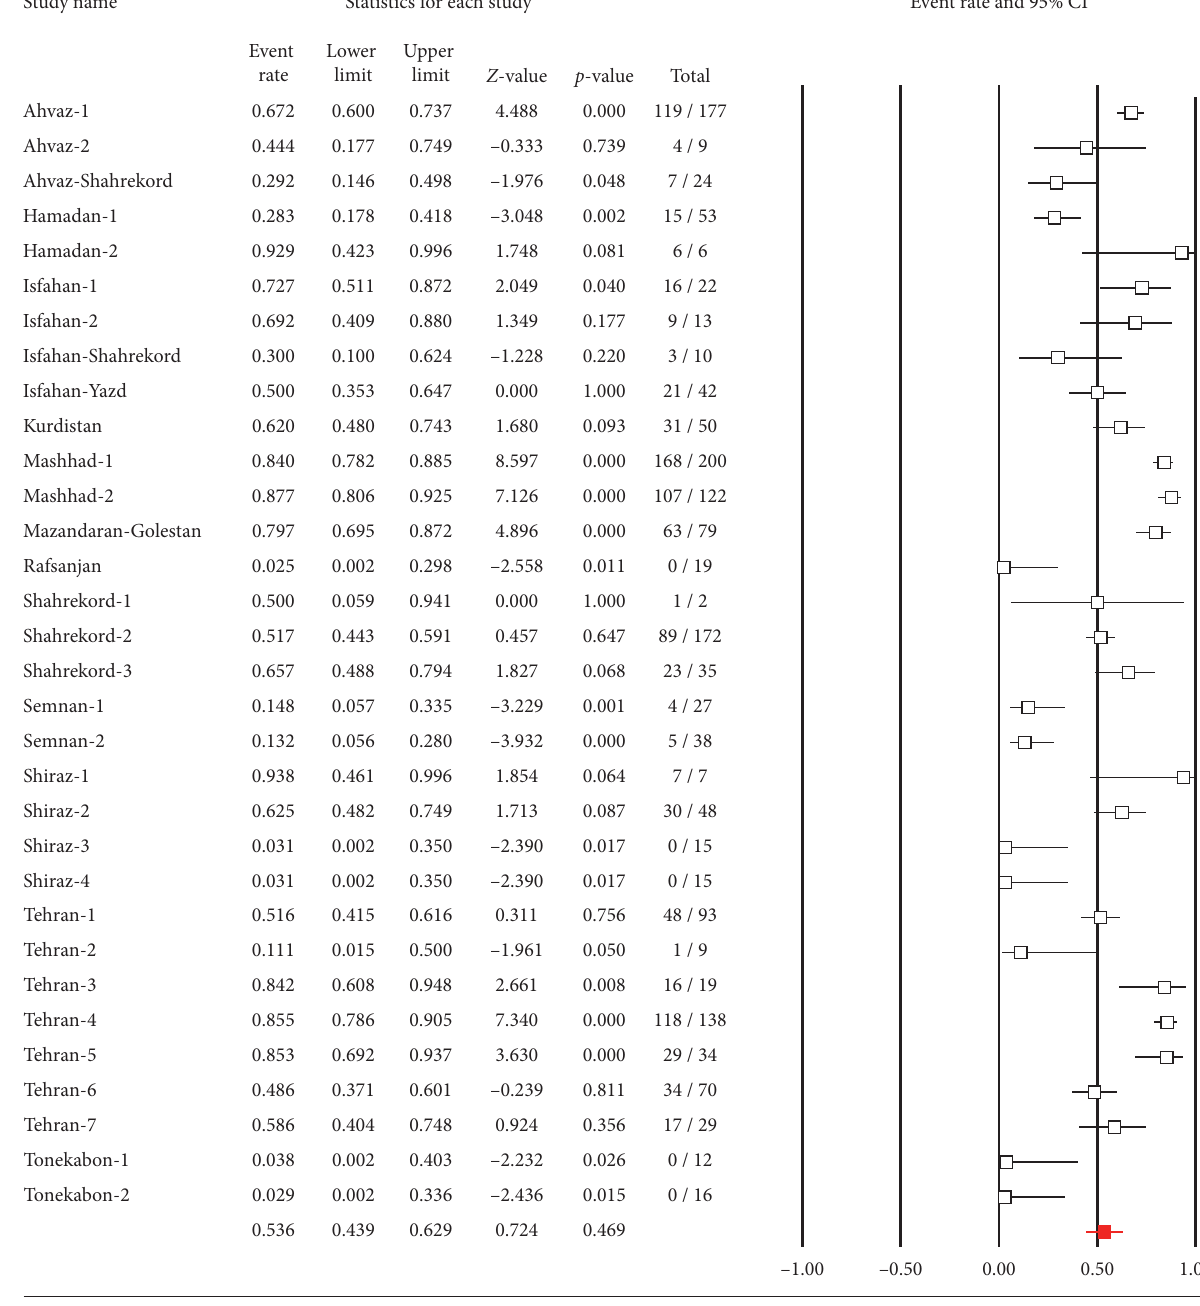
Figure 2: Funnel plot of the meta-analysis of the prevalence of C. jejuni resistant to ciprofloxacin in